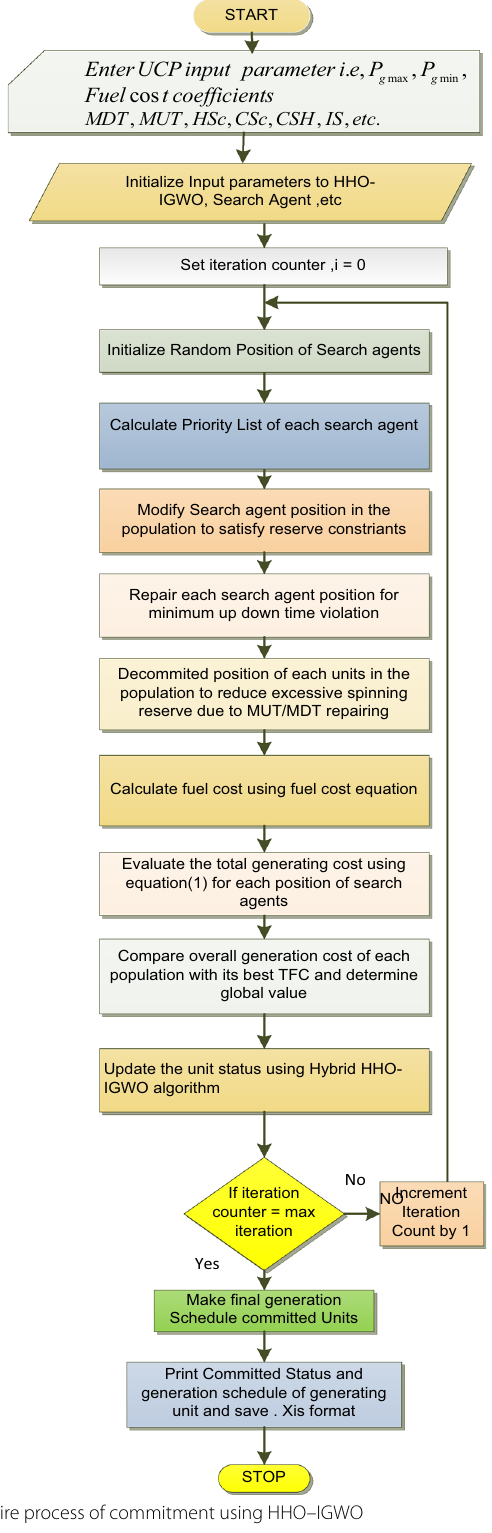
Fig. 4 Flowchart of entire process of commitment using